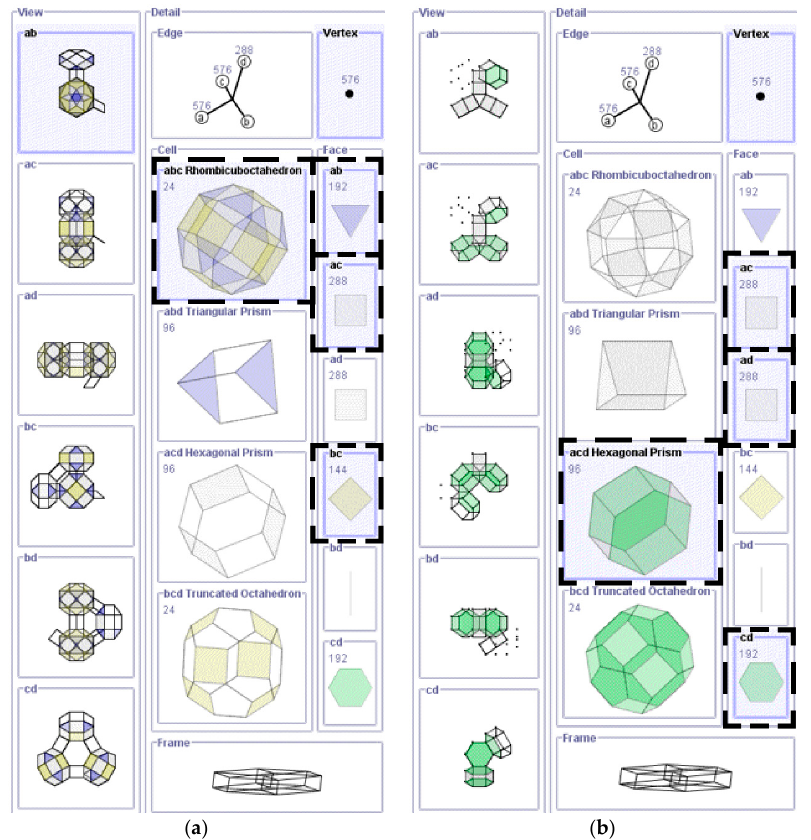
Figure 11. Examples of controls within Polyvise working in synchronization. When 3D cells are filtered out, the filter controls for 2D faces belonging to the filtered-out cells are also deselected (both a and b). Effects of reducing the scope of an object are reflected in the representations of the controls for accessing the standard views (see “view” column in both a and b).